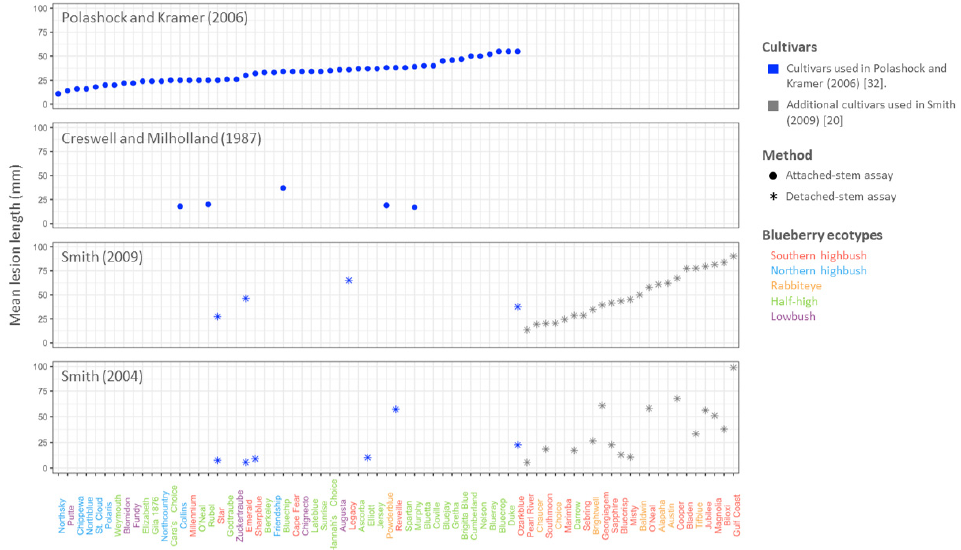
Figure 4. Stem blight resistance of blueberry cultivars of five ecotypes measured in mean lesion length (mm). Southern highbush ( V. corymbosum L. interspecific hybrids), northern highbush ( V. corymbosum L.), rabbiteye ( V. virgatum Aiton), half-high ( V . corymbosum L. × V . angustifolium Aiton), and lowbush blueberries ( V. angustifolium Aiton). Blue dots represents cultivars used in Polashock and Kramer (2006) [32] and grey dots represents additional cultivars in Smith (2009)